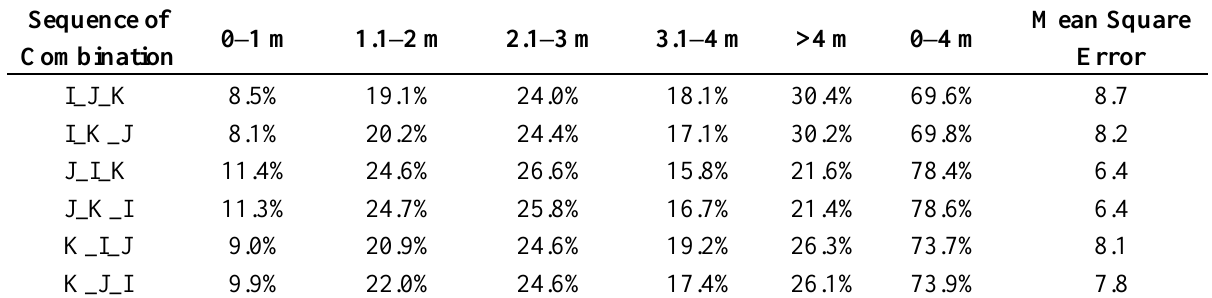
Table 6. Results of different order of three APs used for neural network training. Sequence